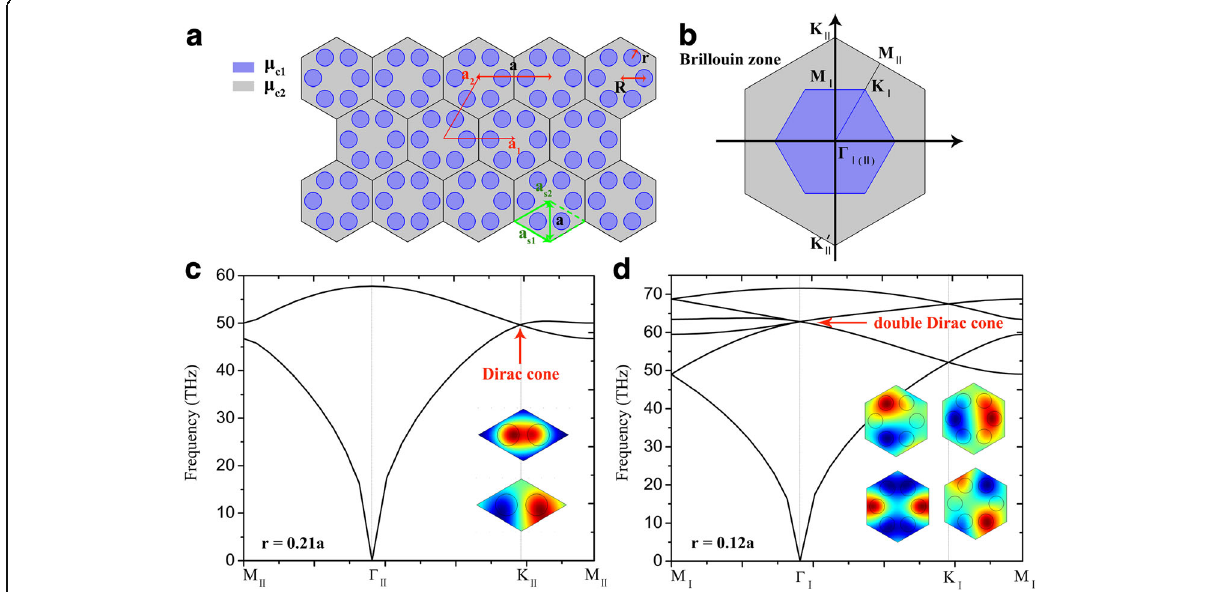
Fig. 1 a Schematics of the 2D GPCs. b The Brillouin zones. c Band structure of the lattice based on the rhombic primitive unit cell indicated with green dashed lines, the insets plot the eigen electric field distributions of the Dirac point. d Band structure of the lattice based on the hexagonal unit cell, the insets plot the eigen electric field distributions of the double Dirac point. The other parameters are set as μ c1 = 0.3 eV, μ c2 = 0.6 eV, τ = 1 ps, the lattice constant a = 40